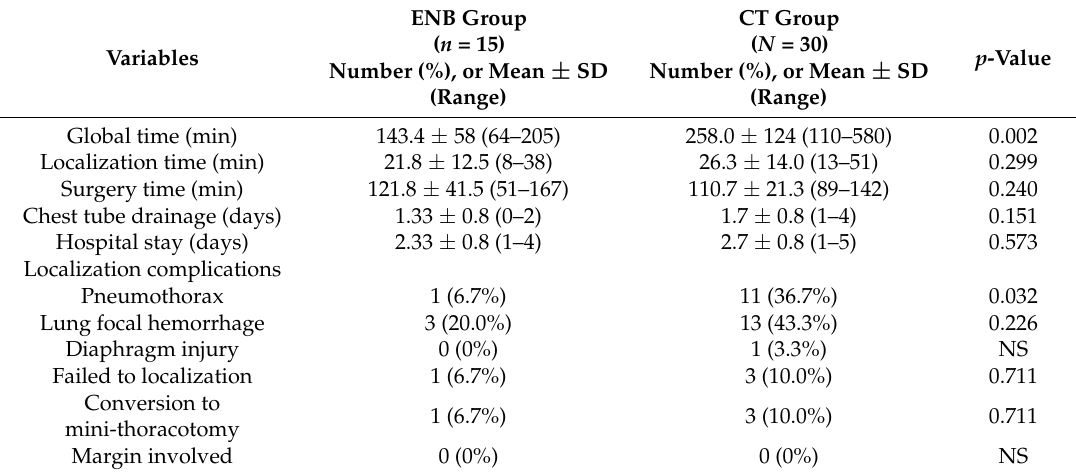
Table 3. Localization and surgery results for the ENB and CT